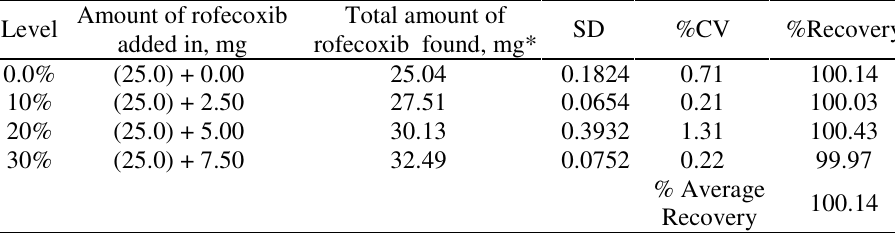
Table 3. Results from recovery analysis for rofecoxib (n=7)